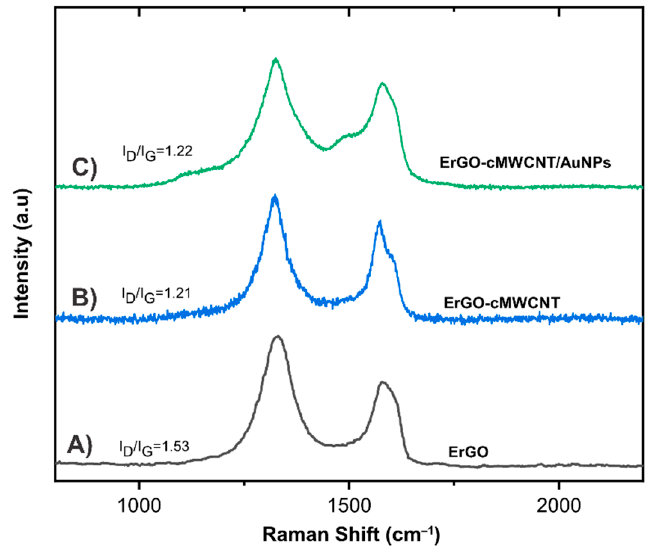
Figure 3. Raman spectra of ( A ) ErGO, ( B )ErGO-cMWCNT, ( C ) ErGO-cMWCNT/AuNPs.